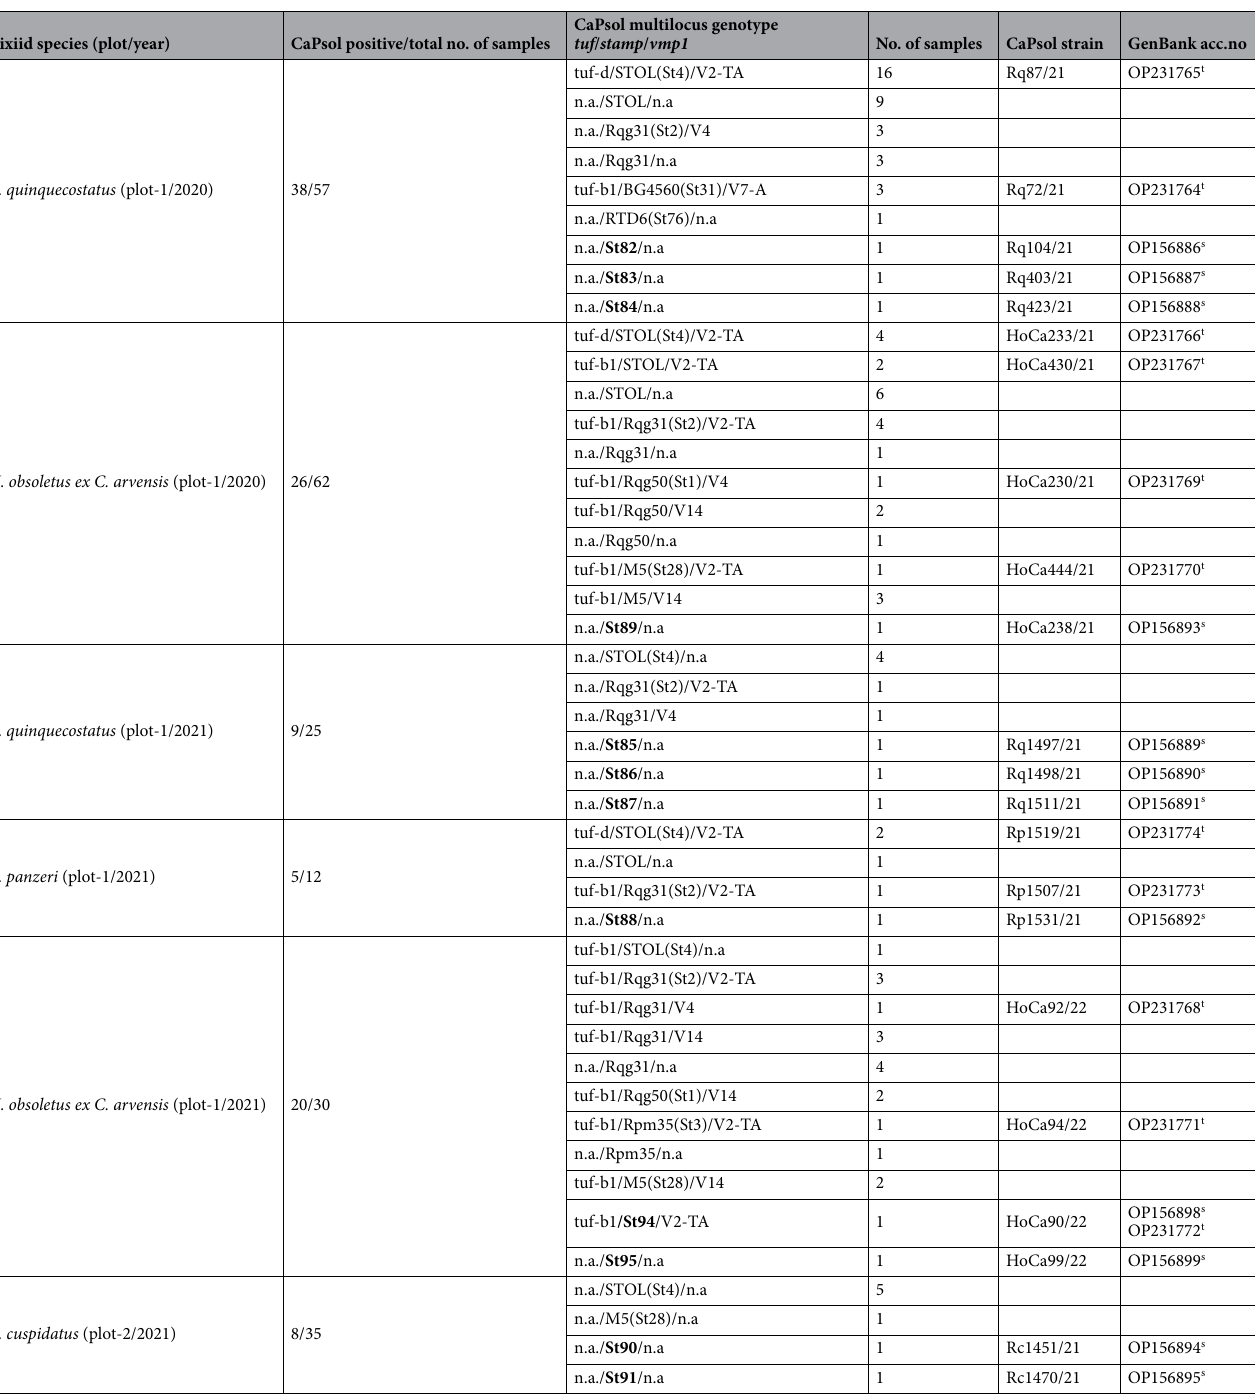
Table 2. CaPsol multilocus genotypes detected in putative cixiid vectors. Affiliated “St” stamp sequence variants are elaborated in Supplementary Table S1; not amplified (n.a.); stamp sequence ( s ); tuf sequence ( t